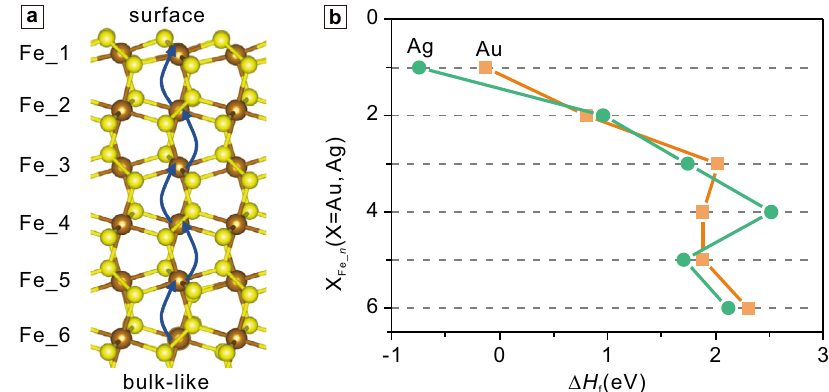
Fig. 3 Thermodynamical properties of gold/silver atoms diffusion from pyrite bulk to the surface. a Schematic of single gold atom substitution on Fe sites in each of the n layers of the pyrite {100} surface. The relative small yellow and large brown spheres denote sulfur and iron atoms, respectively. b Formation enthalpy ( Δ H f ) of gold and silver substitution on Fe sites as a function of substitution depth for pyrite {100}